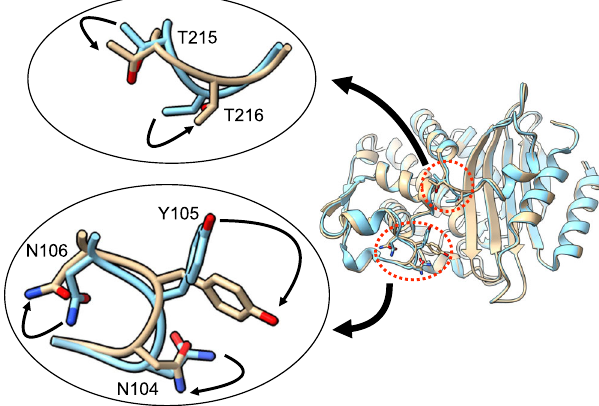
Fig. 5 | Conformational changes in CTX-M-15 β -lactamase associated with bindingofBLIP. TheribbondiagramatrightshowsastructuralalignmentofCTX- M-15 apo-enzyme (blue) (PDB id: 4HBT) with the CTX-M-15 enzyme from the binding complex with BLIP (tan) (BLIP not shown for clarity). Conformational changes are seen in the BLIP-bound CTX-M-15 enzyme in the Val103-Asn106 turn region of the protruding loop as well as the Gly113-Ser220 loop containing Thr215 and Thr216. The insets show the conformational changes with the arrows showing the direction of change from CTX-M-15 apo to BLIP-bound